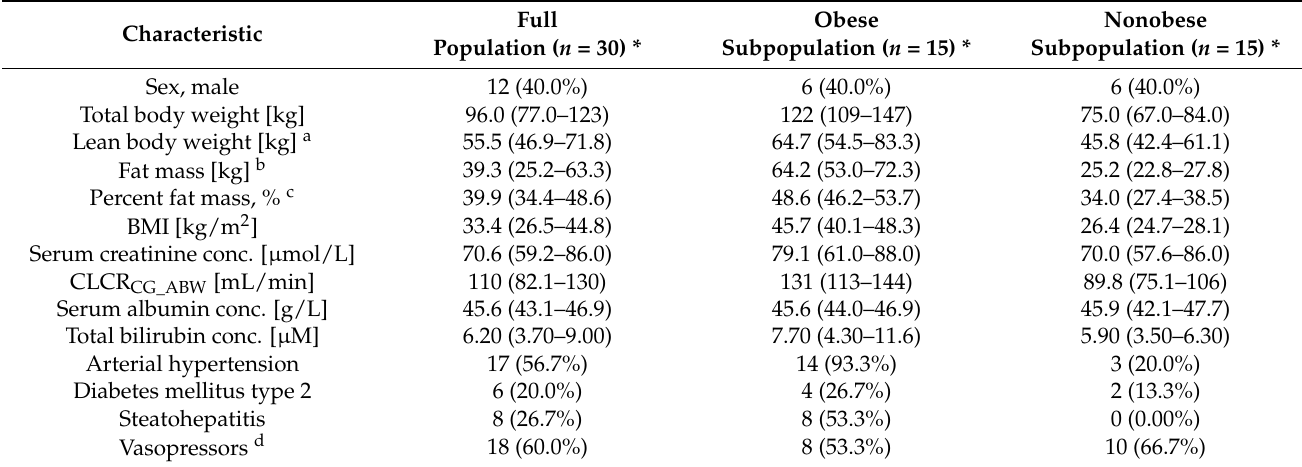
Table 3. Patient-specific characteristics of obese and nonobese patients.